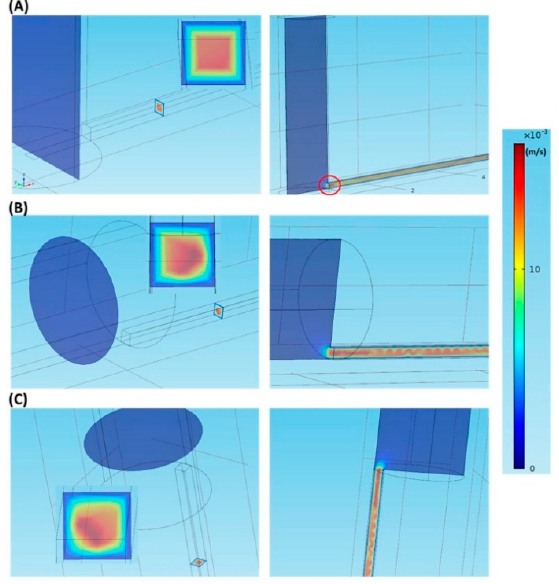
Figure 1. The velocity fields in different inlets at a flow velocity of 0.0001 m/s. ( A ) The vertical inlet; ( B ) The parallel inlet; ( C ) The vertically parallel inlet.